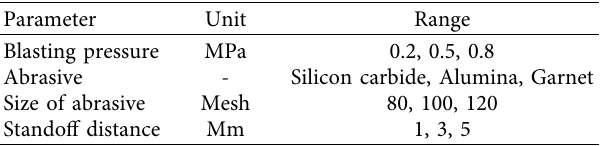
Figure. 1: Schematic layout of fiber recovery and coated abrasive disc production Table 1: Parameter and its experimental range for the sandblasting